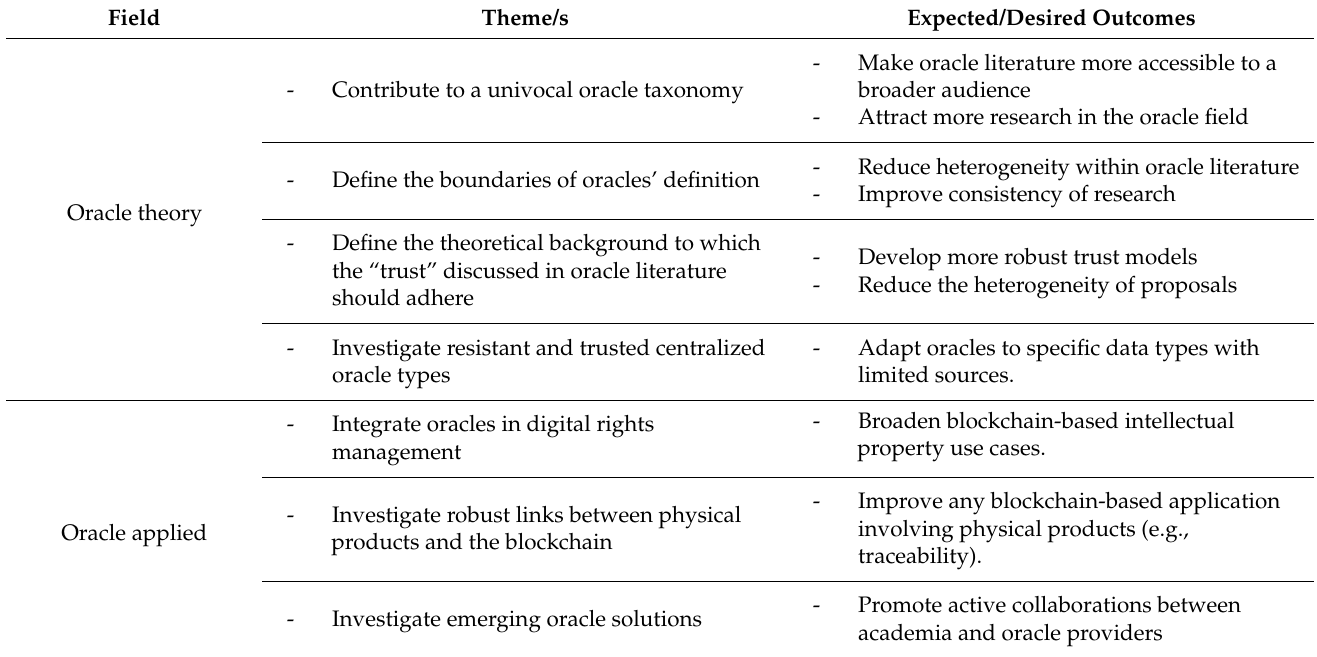
Table 14. Suggested research